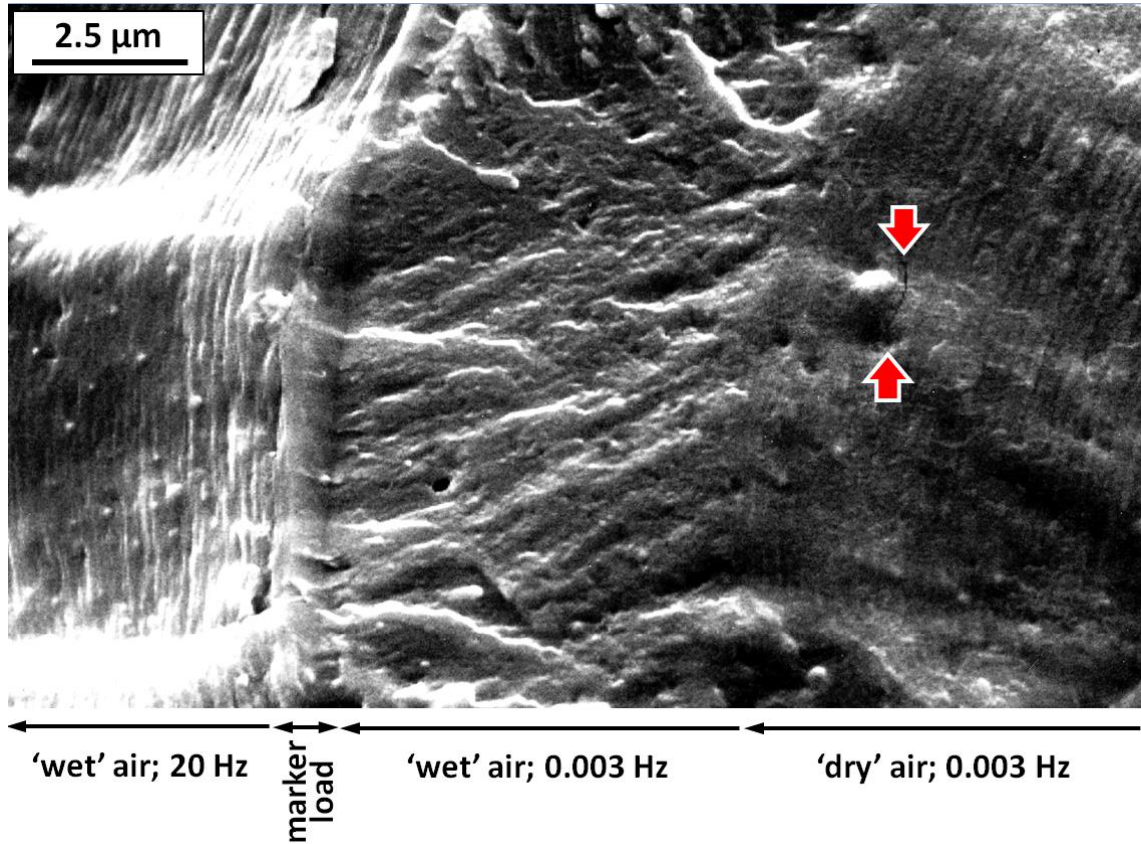
Figure 3. Continuum-mode (fatigue striations) fracture surface change when cycling from ‘dry’ to ‘wet’ air at 0.003 Hz reprinted with permission from [25] for AA2024-T3 aluminium alloy. The arrows indicate a crack in a superficial corrosion layer that formed on the ‘dry’ striation growth region during cycling in ‘wet’ air.